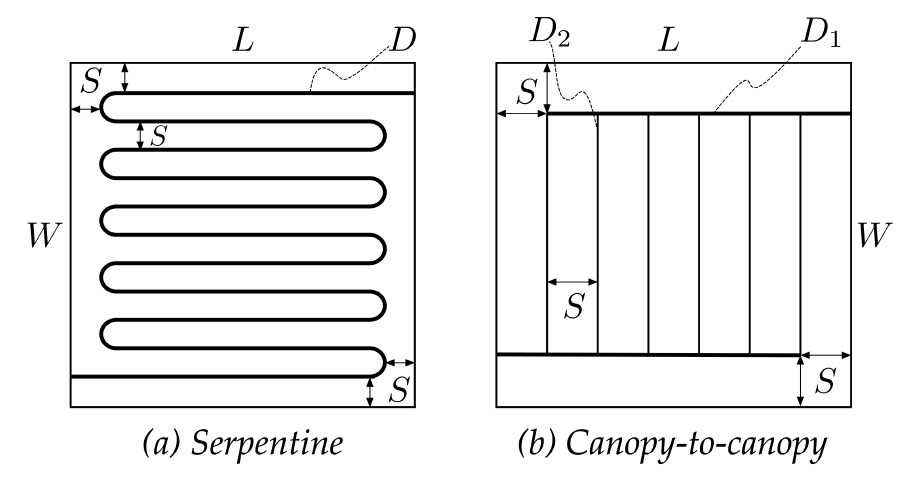
Figure 6. ( a ) Serpentine and ( b ) canopy-to-canopy configurations investigated in Mosa et al. [26].